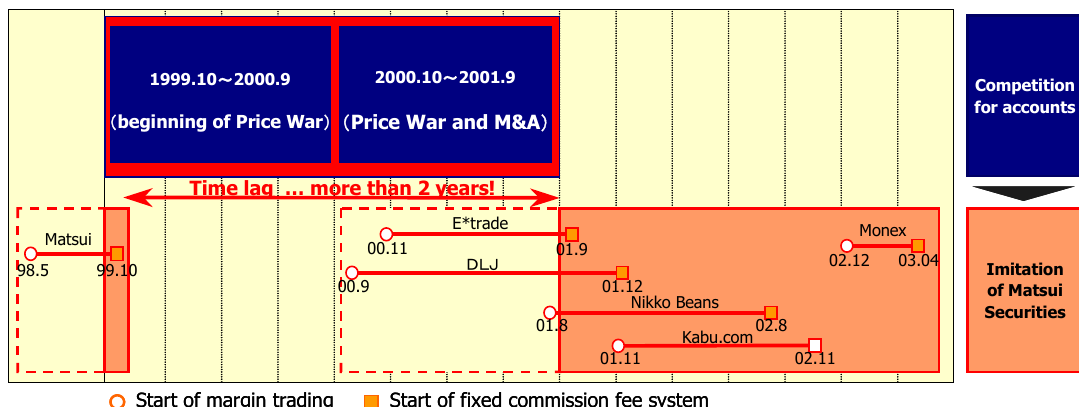
Figure 6. Imitation of Matsui Securities